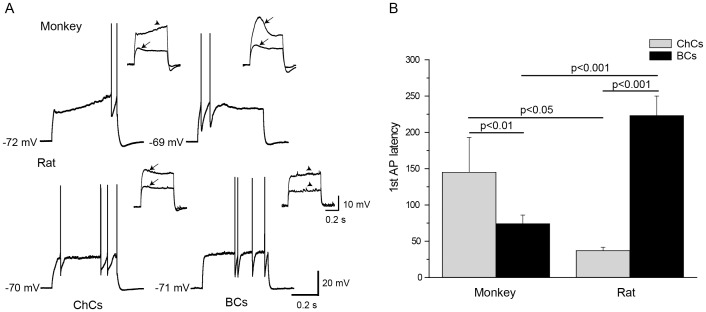
ChCs and BCs differences in the 1st AP latency.A. Representative traces with the first AP in in monkey and rat ChCs and BCs. ChCs but not BCs showed delayed 1st AP/depolarizing ramp at near-threshold levels of stimulation currents in monkey PFC. On the contrary, in rat, BCs but not ChCs showed delayed 1st AP/depolarizing ramp at the near-threshold levels of stimulation currents. Insets: BCs but not ChCs demonstrate hump (arrow) at the sweeps just below firing threshold in monkey PFC. Ramp (arrowhead) is observed in a number of chandelier cells. On the contrary, in rat PFC, ChCs but not BCs demonstrate hump at the subthreshold sweeps. Flattened response (arrowhead) is observed in BCs but not ChCs from rat. B. Quantification of population data for the 1st AP latency. Note different direction of ChCs-BCs differences in monkey and rat. Error bars represent SE.